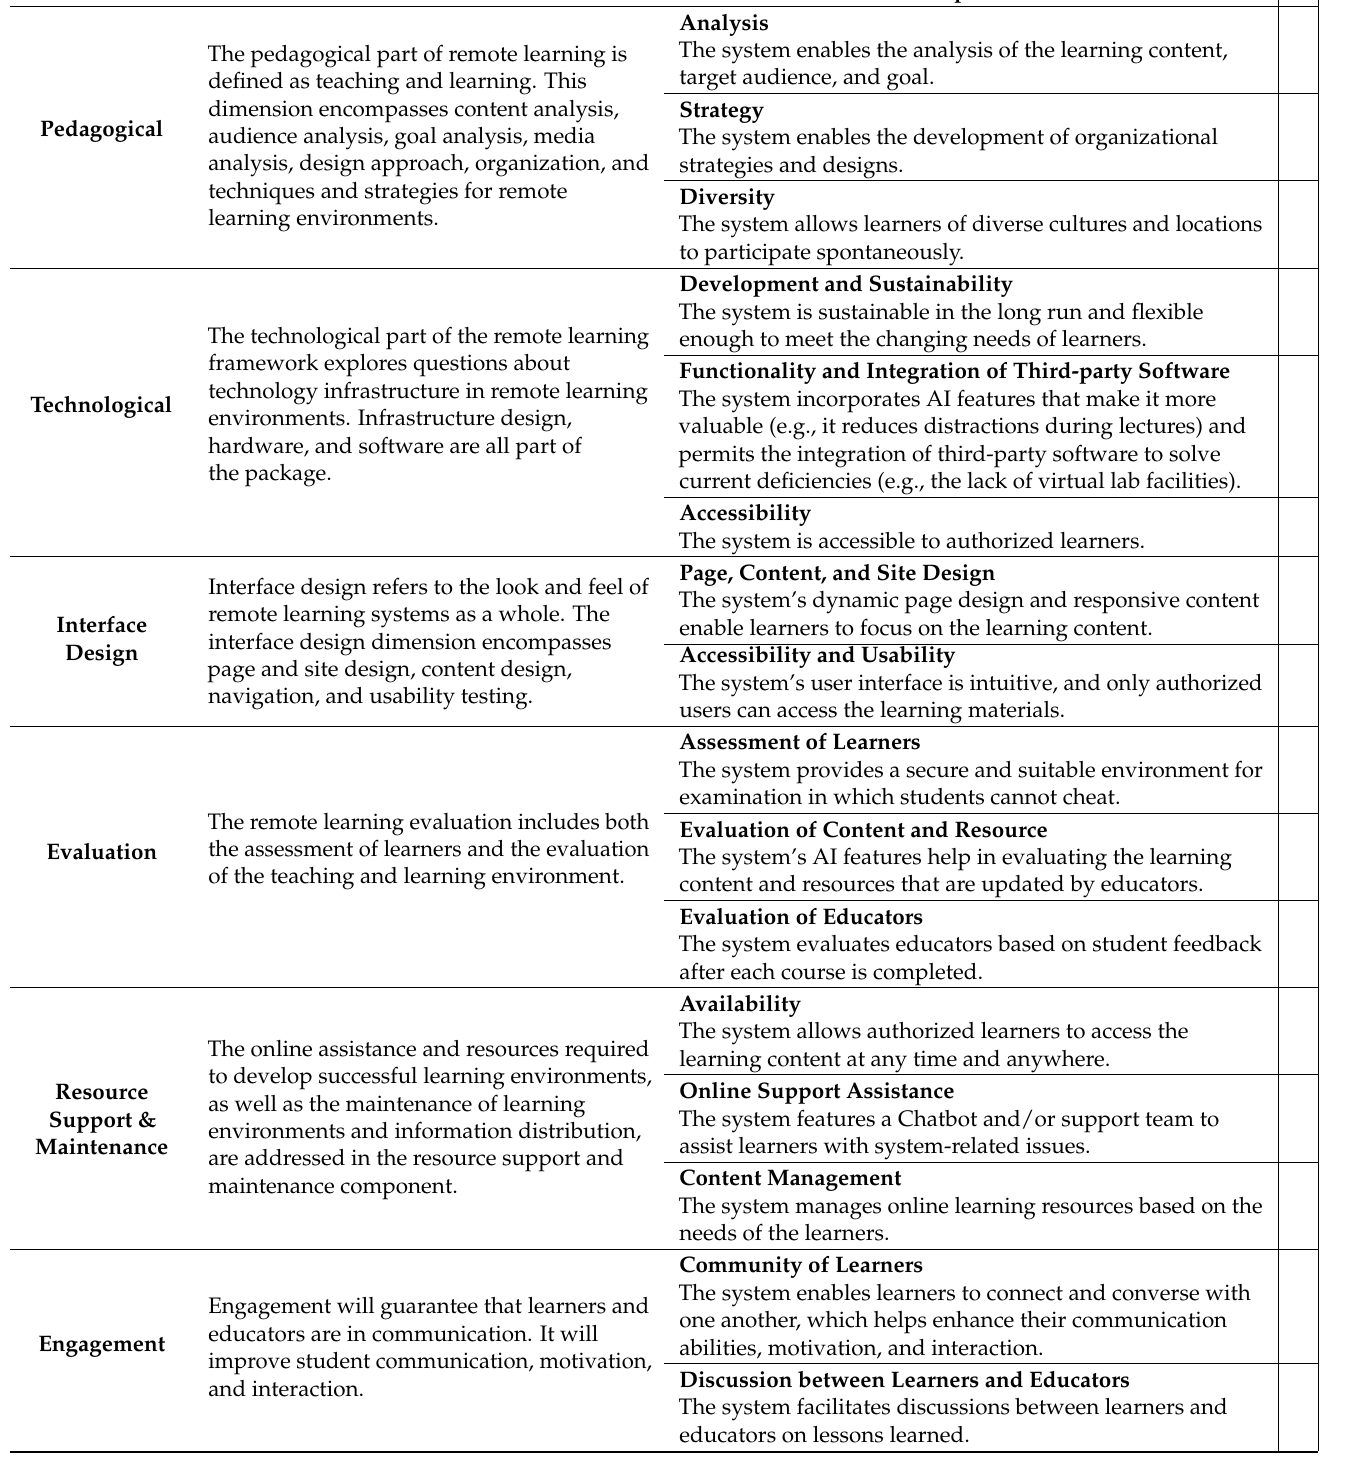
Table 6. C19MOOC remote learning reference framework